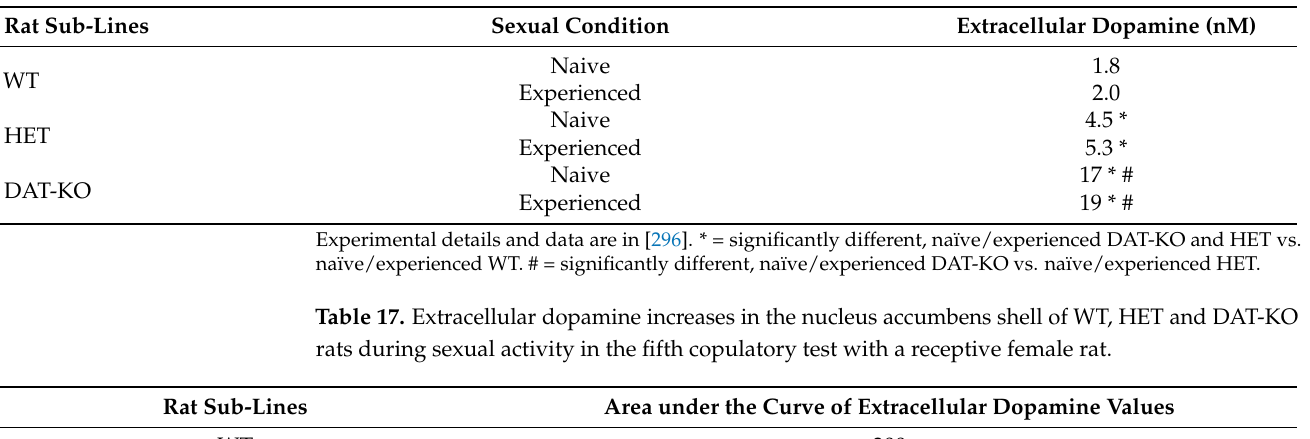
Table 16. Basal levels of extracellular dopamine in the nucleus accumbens shell of DAT-KO, HET and WT rat sub-lines at the first (sexually naïve condition) and at the fifth copulatory test (sexually experienced condition) with a receptive female rat.